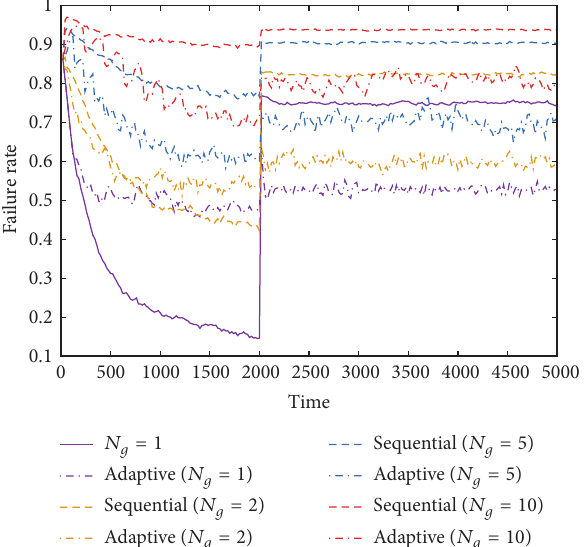
Figure 11: The simulation results of P-EP2P using the sequential topology evaluation method (labeled as “sequential”) and P-EP2P with the adaptive strategy (labeled as “adaptive”) for the evaluation scenario including dynamic environmental change, where all nodes always stay in the network.